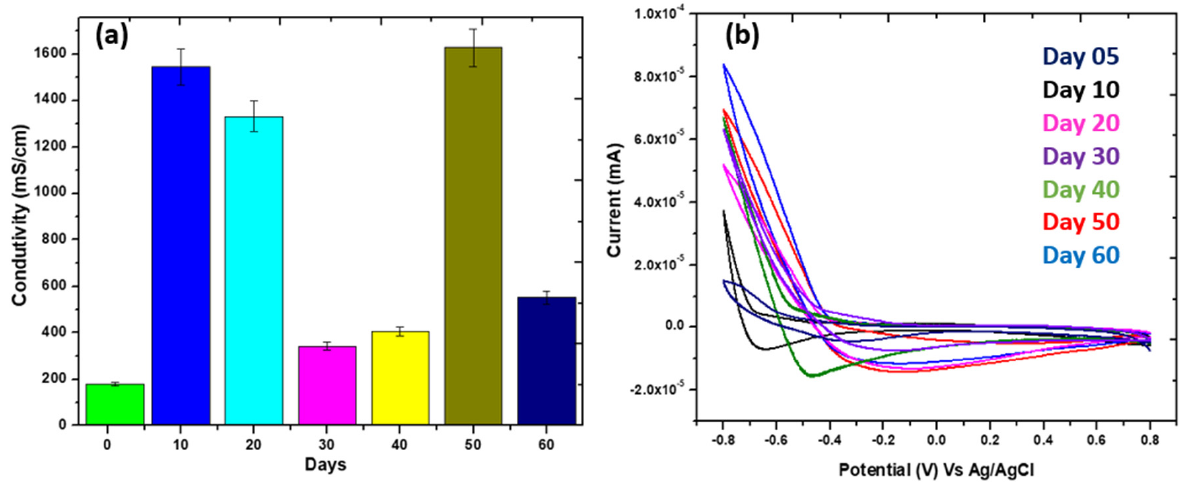
Figure 3. ( a ) Values of conductivity at various time intervals and ( b ) CV curves.